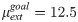
Results in a network of 10 × 10 planning neurons with different noise scenarios.Start position at (7,9), goal position at (7,3) and obstacle indicated by the black bar. Top row: voltage of the four nearest neighbor neurons at the start position (identity color coded). Middle row: external input current these neurons receive. Bottom row: 2D environment with the chosen path (blue line) from the start to the goal. Standard deviations σ
ext of the input currents indicated below. a, b: The mean of the input current generated by the background Poisson spiking neuron was constant and identical for all neurons (μ
ext = 12 mV/ms), except for the goal neuron (marked with g, μextgoal=12.5). c: A common sinusoidal fluctuation in the Poisson firing rate of the background neurons does not disturb the relative timing among neighboring neurons. d: A randomly chosen bias in the mean μextij of the individual input currents with standard deviation 3 does not prevent the agent from finding a short path to the goal. In all simulations, the planning times were 600 ms, the readout times 250 ms, and the coupling strength was ϵ = 0.15.